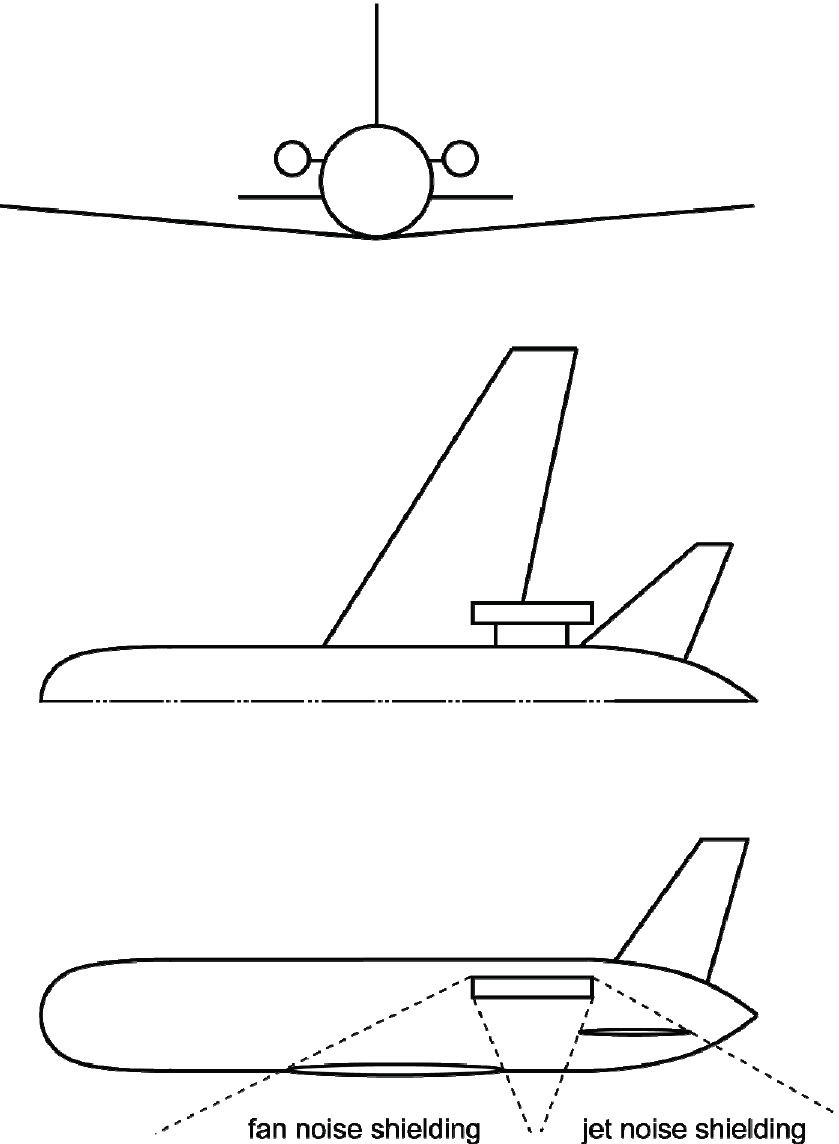
Figure 18. Low-noise cruise-efficient aircraft configuration I: turbofan. The lowest-noise aircraft configuration within mature technology and historic data available for the next generation could have: (i) a conventional fuselage with low-wing and mid-set tailplane; (ii) a carefully positioned engine nacelle to maximize shielding of forward noise by the wing and shielding of aft noise by the tailplane. Jet noise and aerodynamic noise need to be minimized by careful nozzle design and wing lift distribution. The inevitable penalties seem tractable: (i) armouring of the engine nacelle on the fuselage side against uncontained turbine blade failure; (ii) countering the moderate pitch-down of relatively high-mounted engines in all flight phases. Other configurations like engines between a U-shaped empennage or an engine nacelle joining the wing to the tailplane may have more severe issues without providing better noise